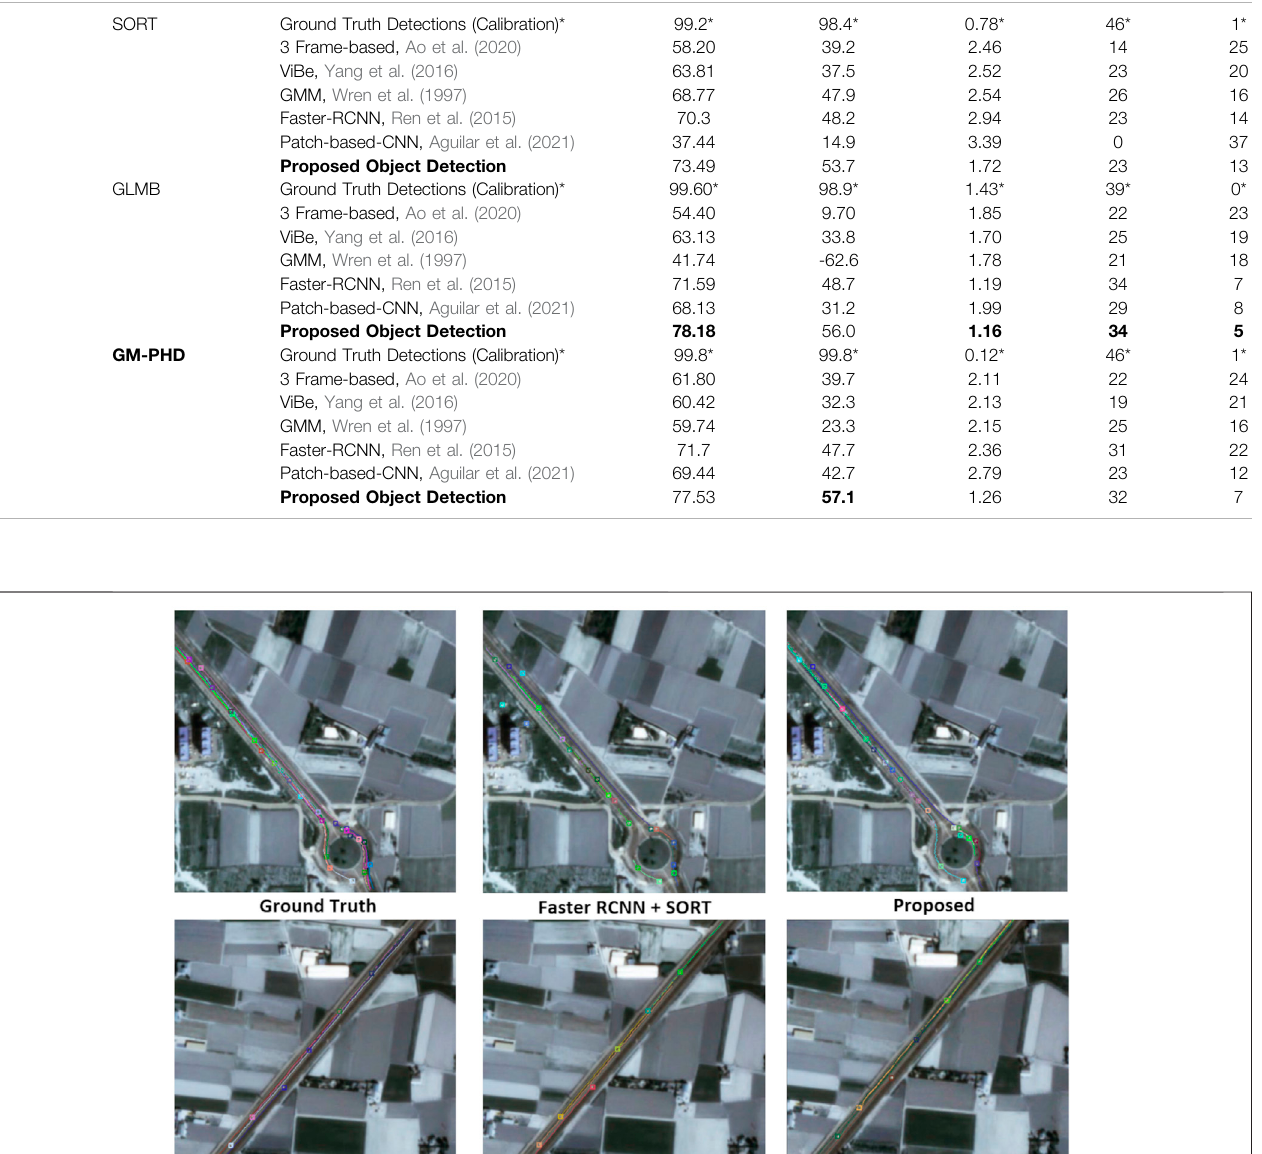
TABLE 6 | Tracking Metrics for AoI 2. *Denotes ground truth measurements used for calibration and fi lter-only testing. AoI Tracker